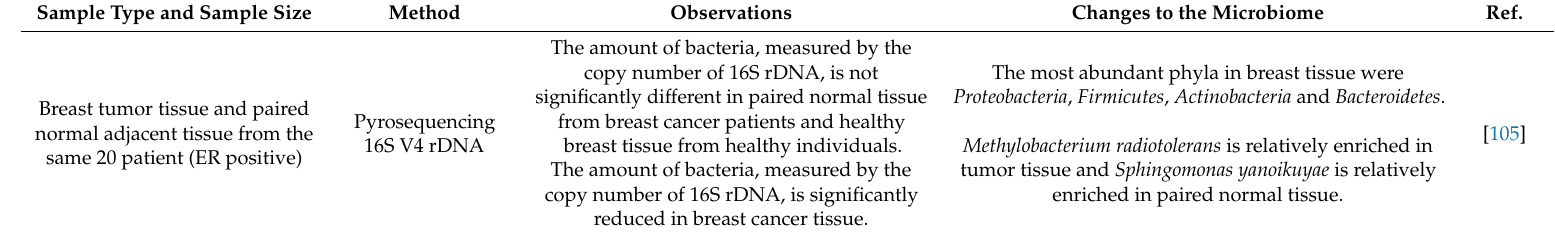
Table 2. Studies investigating changes to the breast microbiome in breast cancer. Abbreviations: ER, estrogen receptor; CNB, Core needle biopsies; HER2, herceptin receptor/erbB receptor; NAF, Nipple aspirate fluid; PR, progesterone receptor; SEB, Surgical excision biopsies; TNBC, Triple negative breast